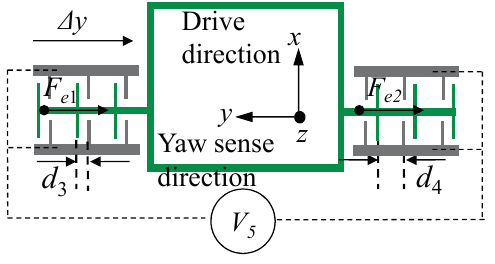
Figure 5. The frequency tuning electrodes in yaw